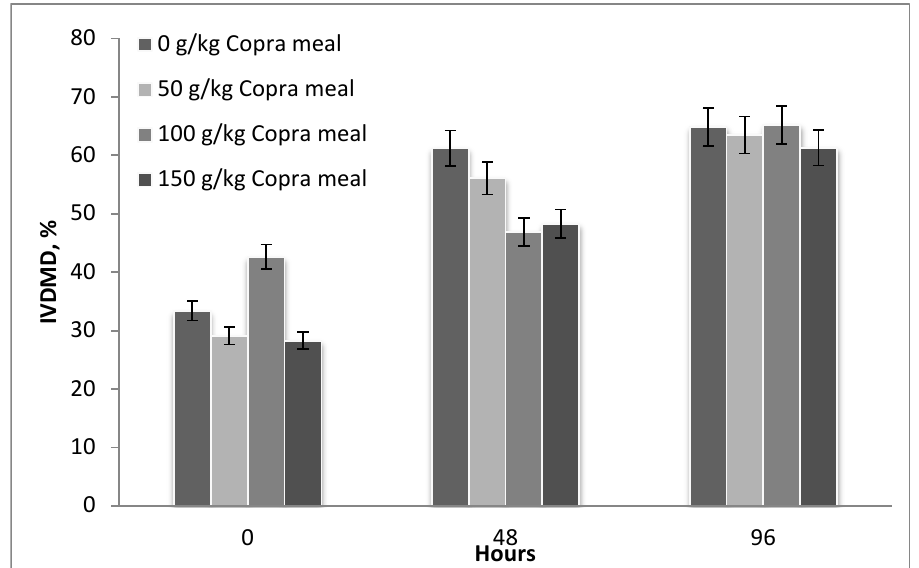
Figure 1. In vitro dry matter digestibility of diets with different amounts of copra meal at 0, 48, and 96 h. The p -values of the linear and quadratic effects: at 0 h (0.51 and 0.04), 48 h (0.03 and 0.9), and 96 h (>0.05 and >0.05).